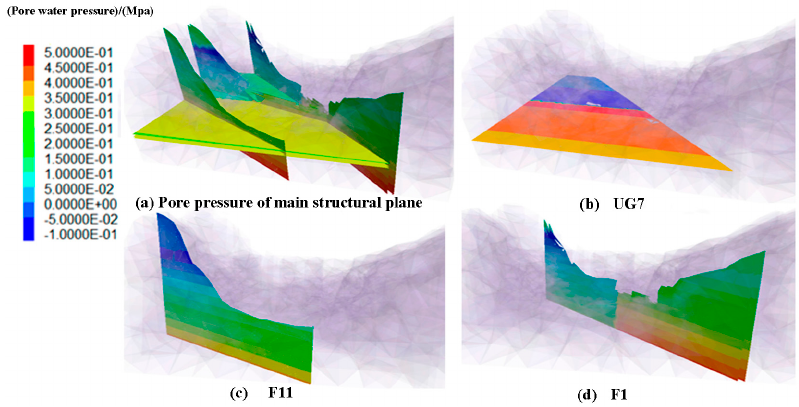
Figure 9. Flood water pressure on the main structural surface of the dam foundation in flood water condition. water